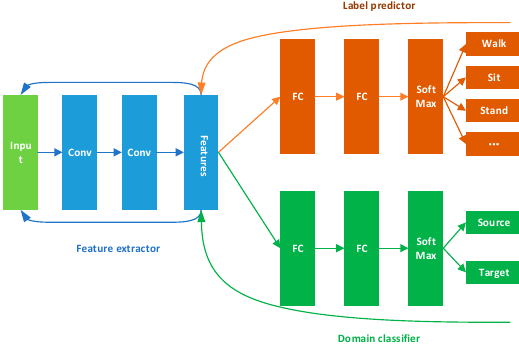
Figure 3. DANN framework, it contains feature extractor, label predictor and domain classifier.